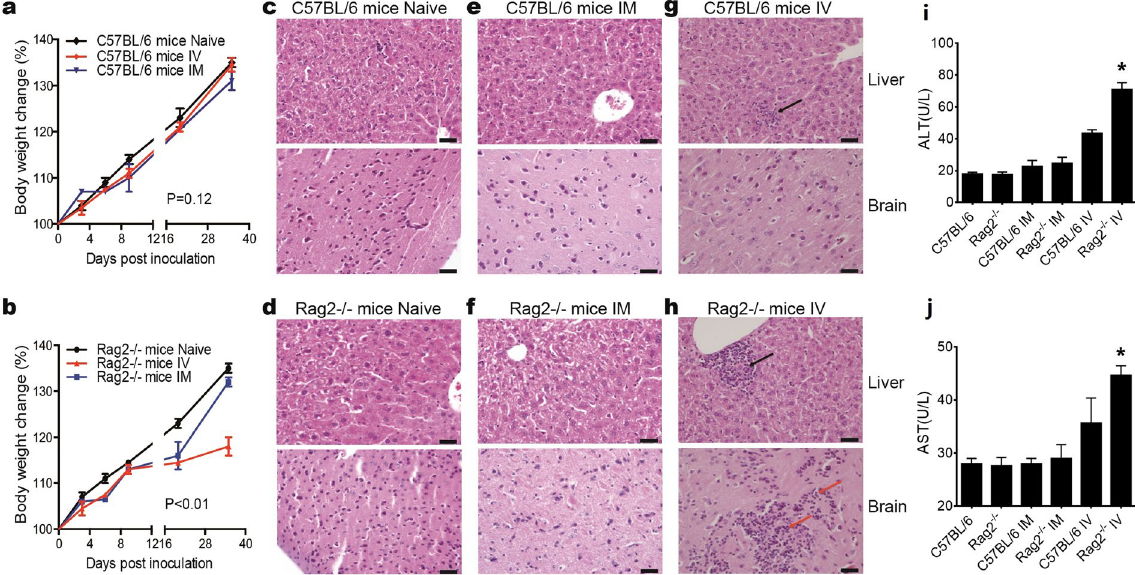
Figure 4. Body weight gain and pathological changes in mice inoculated with Ad5-Fluc. ( a , b ) Body weights of C57BL/6 mice ( a ) and Rag2 − / − mice ( b ) inoculated with Ad5-Fluc via the IV or IM route were recorded (n = 5). ( c , h ) A histopathological analysis of each group, naïve C57BL/6 mice ( c ); naïve Rag2 − / − mice ( d ); C57BL/6 mice inoculated via IM ( e ); Rag2 − / − mice inoculated via IM ( f ); C57BL/6 mice inoculated via IV ( g ); and Rag2 − / − mice inoculated via IV ( h ), was performed systematically on day 35 after inoculation with 5 × 10 10 pfu/ kg Ad5-Fluc. Paraffin-embedded tissue sections were stained with haematoxylin and eosin, and arrows indicate the lesion sites. Scale bar, 20 μ m. Effects on the activities of serum ( i ) alanine aminotransferase (ALT) and ( j ) aspartate aminotransferase (AST). * Indicates that there is a significant (P < 0.05) difference between the treatment group and the control